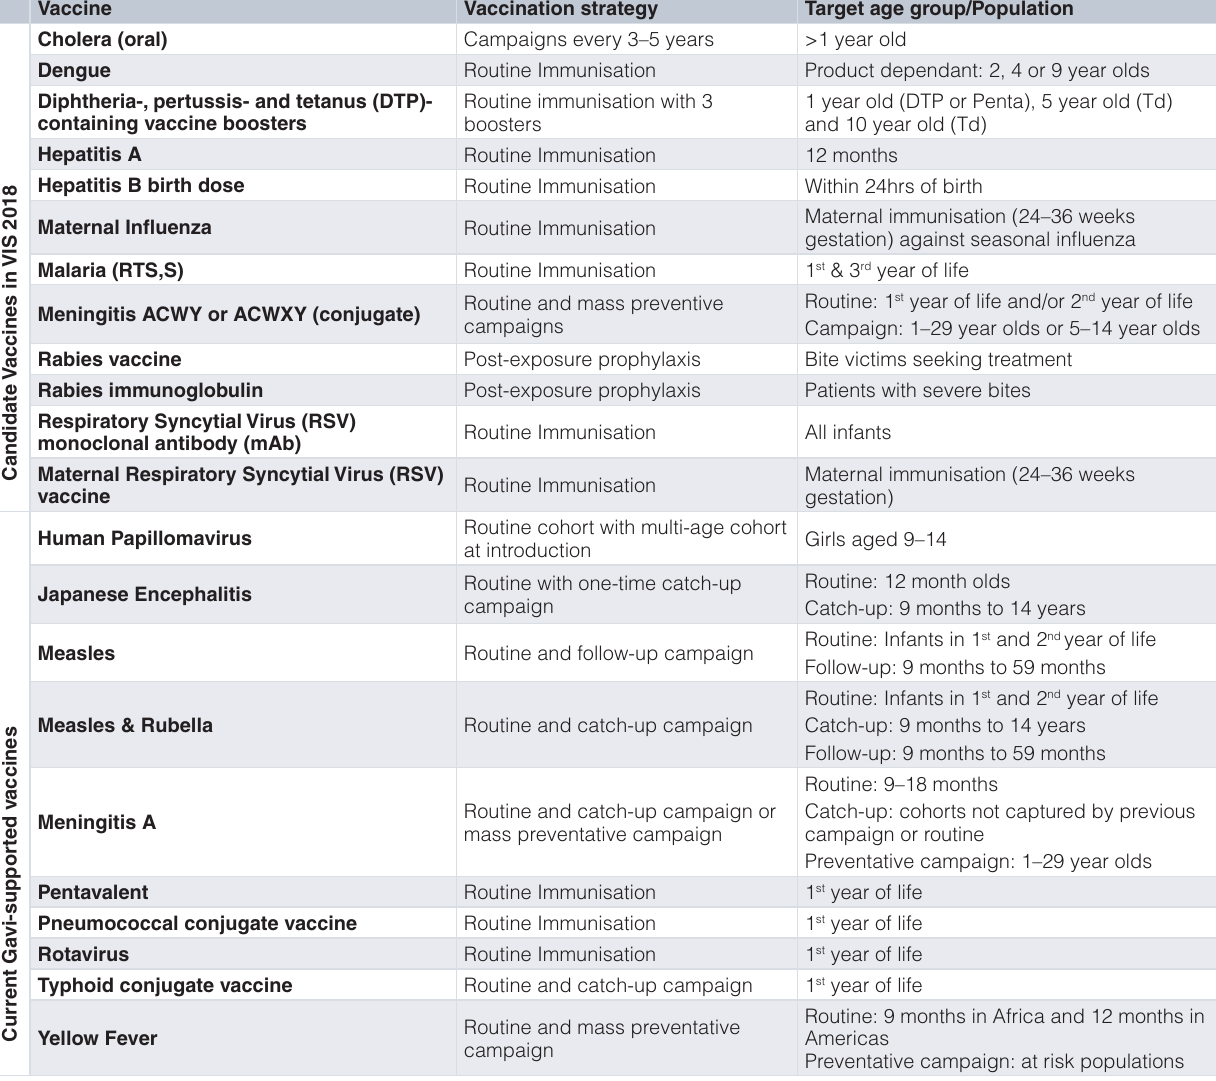
Table 1. Vaccines and associated vaccination strategies evaluated. DTP (Diphtheria-, pertussis and tetanus); Penta (pentavalent vaccine); Td (tetanus and diphtheria booster vaccine); Meningitis ACWY or ACWXY (meningitis vaccine against A, C, W, Y strains or A, C, W, X, Y strains); RSV (respiratory syncytial virus); mAb (monoclonal